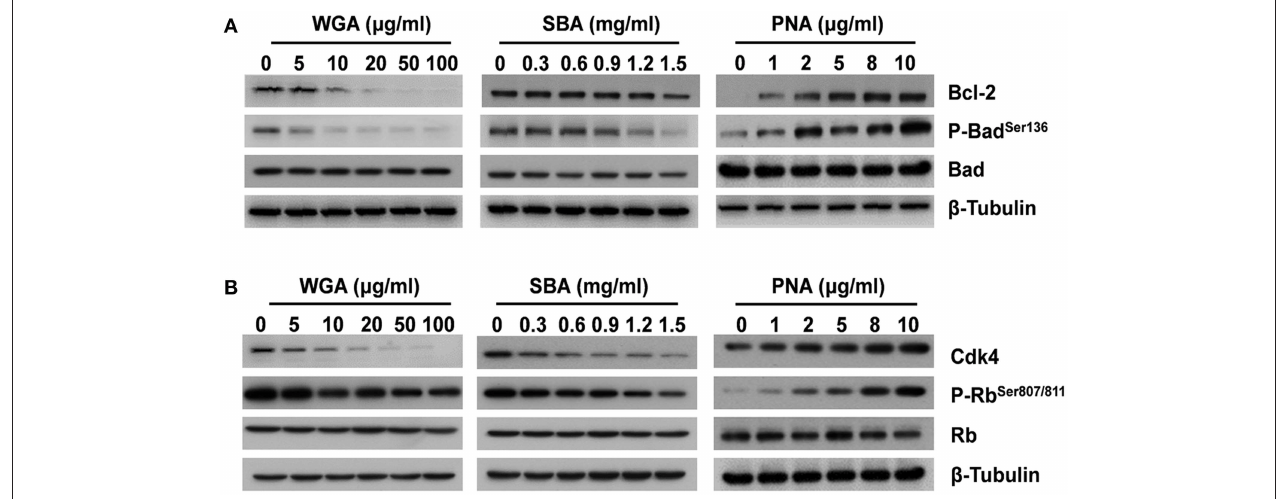
FIGURE 2 | The influence of lectins on biomarkers of cell apoptosis and proliferation. Cells were treated with series concentrations of WGA or SBA for 9h. Serum starved cells were treated with indicated concentrations of PNA for 48h. (A) The levels of total and phosphorylated forms of Bad and Bcl-2 were examined by western blot. (B) The levels of total and phosphorylated forms of Rb, and Cdk4 were examined by western blot.